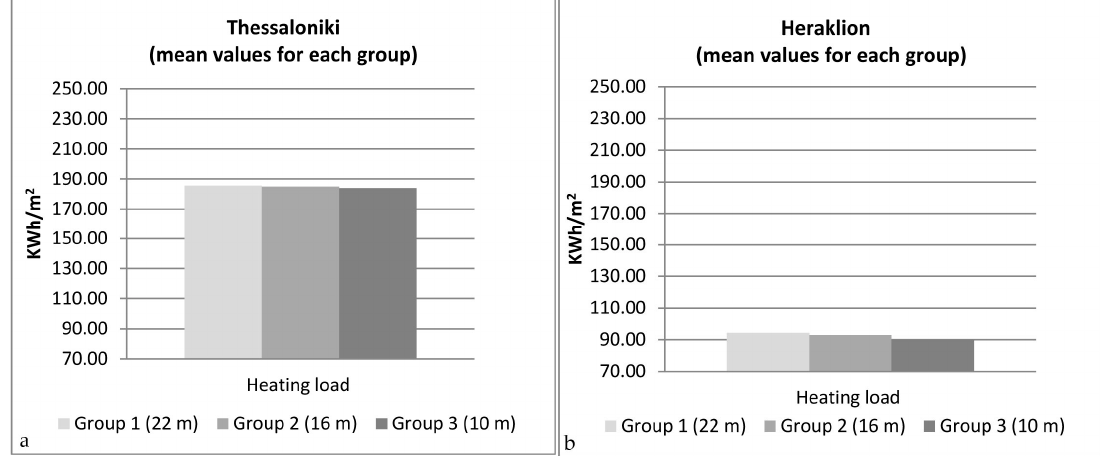
Figure 9. Histogram presenting mean values for the heating loads calculated for each group of urban blocks for the climatic conditions of ( a ) Thessaloniki and ( b ) Heraklion.